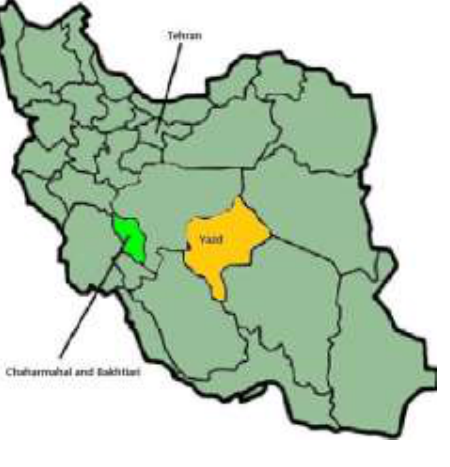
Fig. 1. Location of studied provinces in Iran